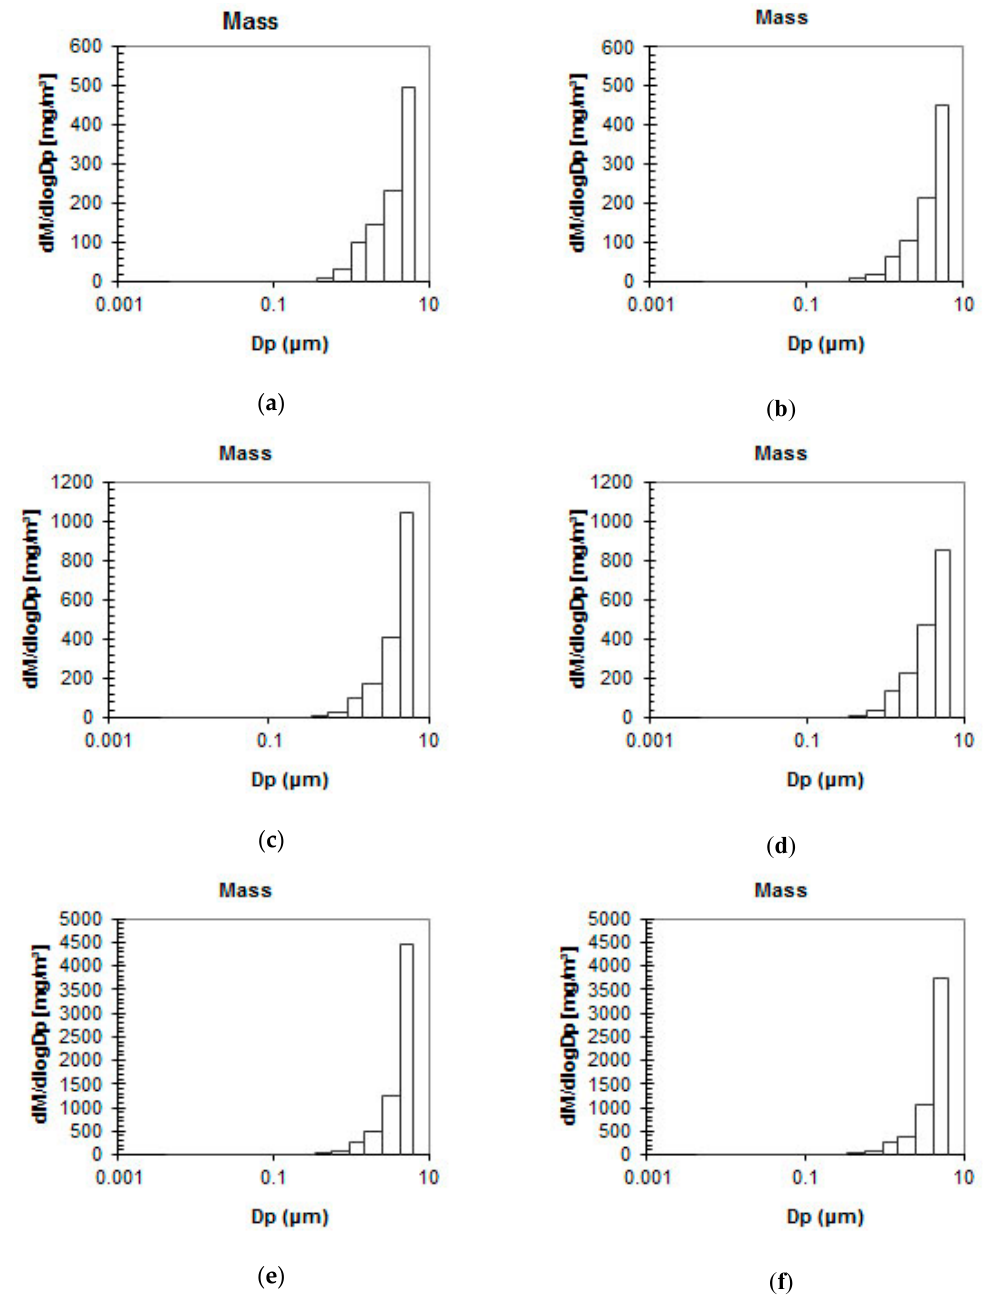
Figure 5. Distribution of mass concentration [mg/m 3 ] for experiments: ( a ) A1; ( b ) A2; ( c ) B1; ( d ) B2; ( e ) C1; ( f ) C2.